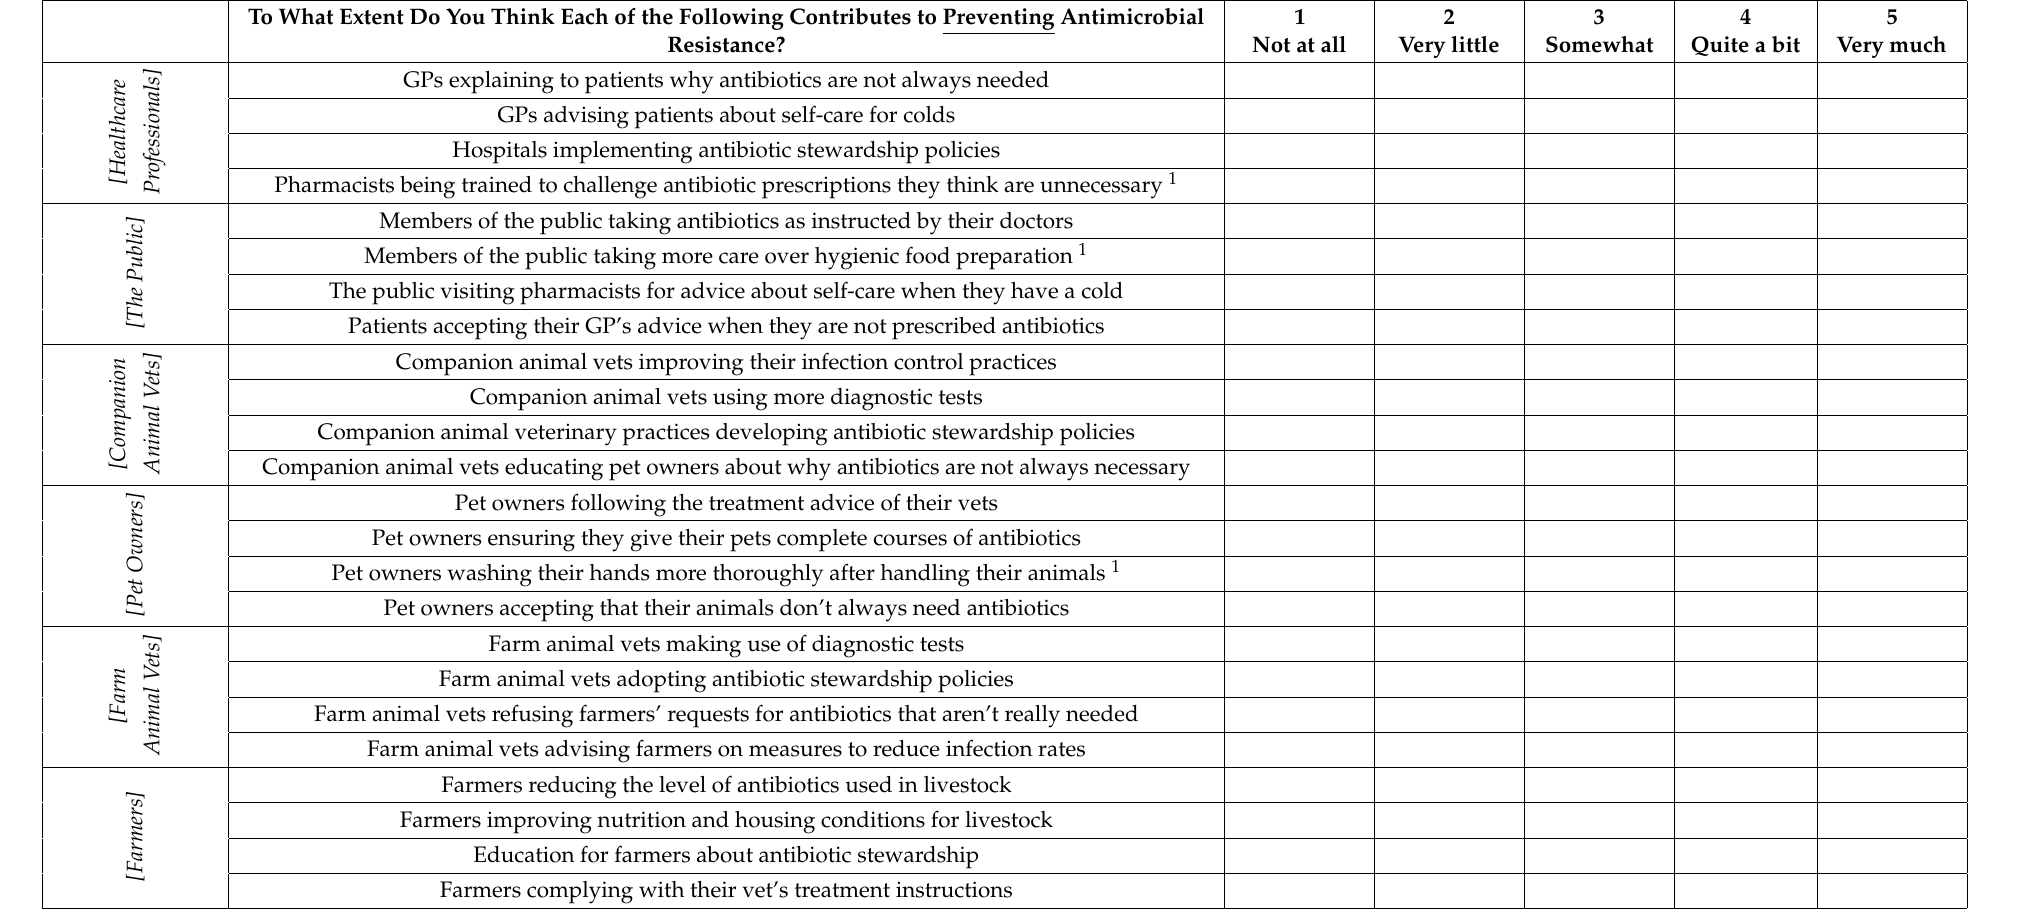
Table A2. Responsibility for preventing AMR